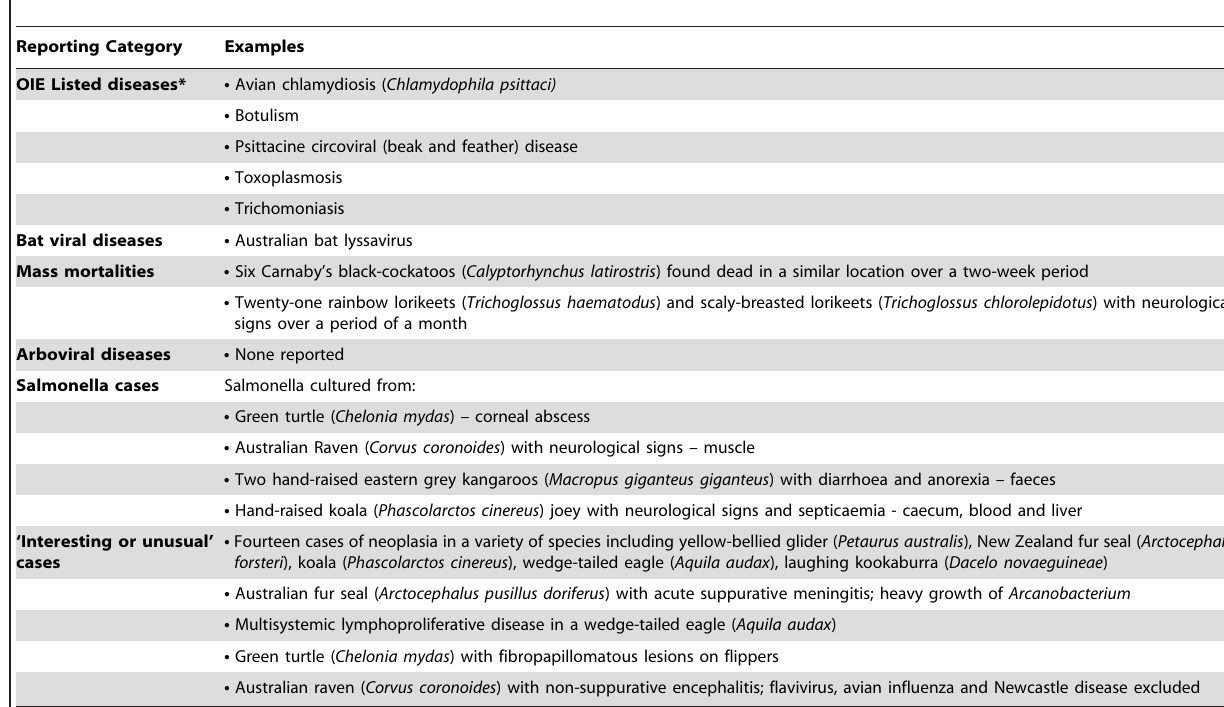
Table 3. Examples of disease events captured for each reporting category (see Table